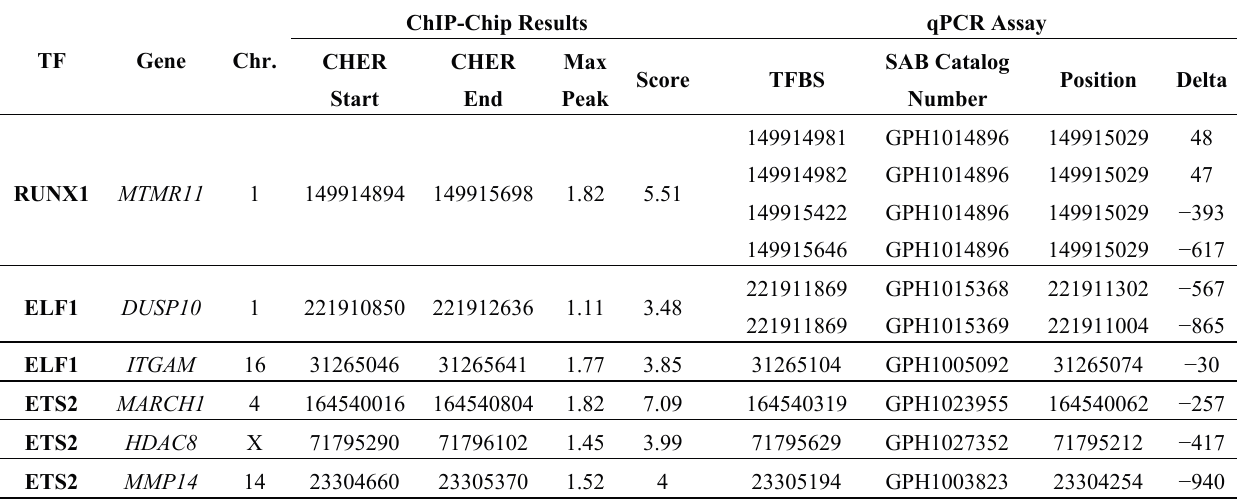
Table 4. List of qPCR assays used in the